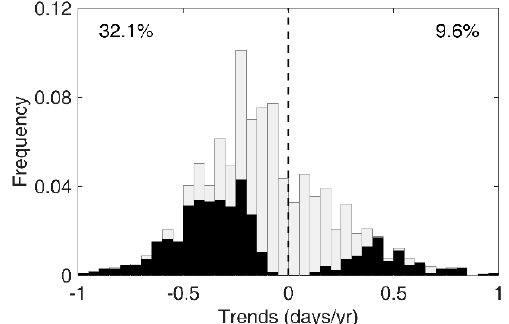
Figure 3. The frequency of WHD variation trends. The black bars indicate significant trends at the significance level of 0.05.